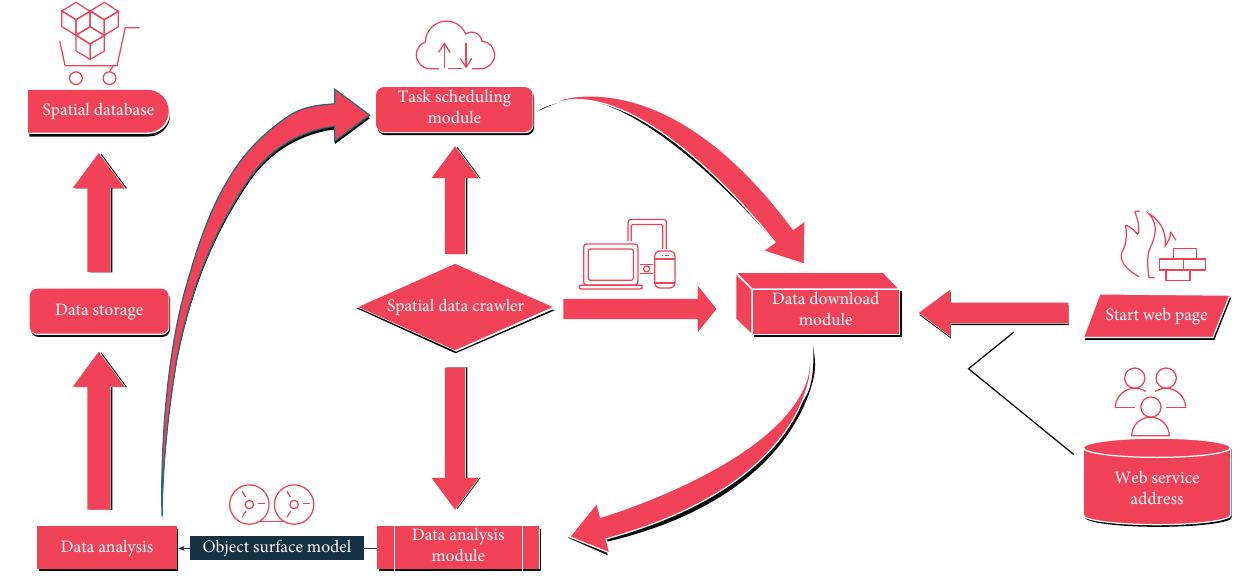
Figure 3: Basic structure of POI data crawler. Table 1: Comparison of di ff erent threshold name similarity